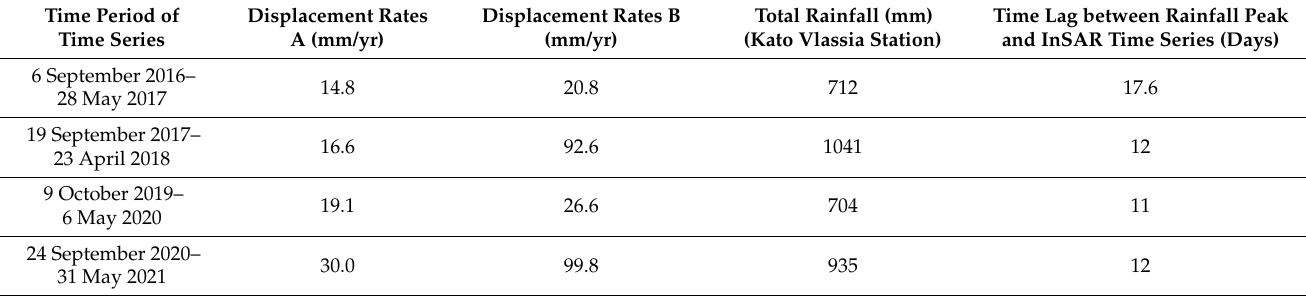
Table 2. Displacement rate A corresponds to the linear displacement rate of the Krini landslide (descending orbit) before the maximum seasonal rainfall is reached, and linear displacement rate B corresponds to the displacement rate following the rainfall peak (see Figure 11 for trendlines). The total rainfall corresponds to the total rain during each time period. The displacement rate A & B values of the last line (period 2020–2021) refers to the ascending orbit